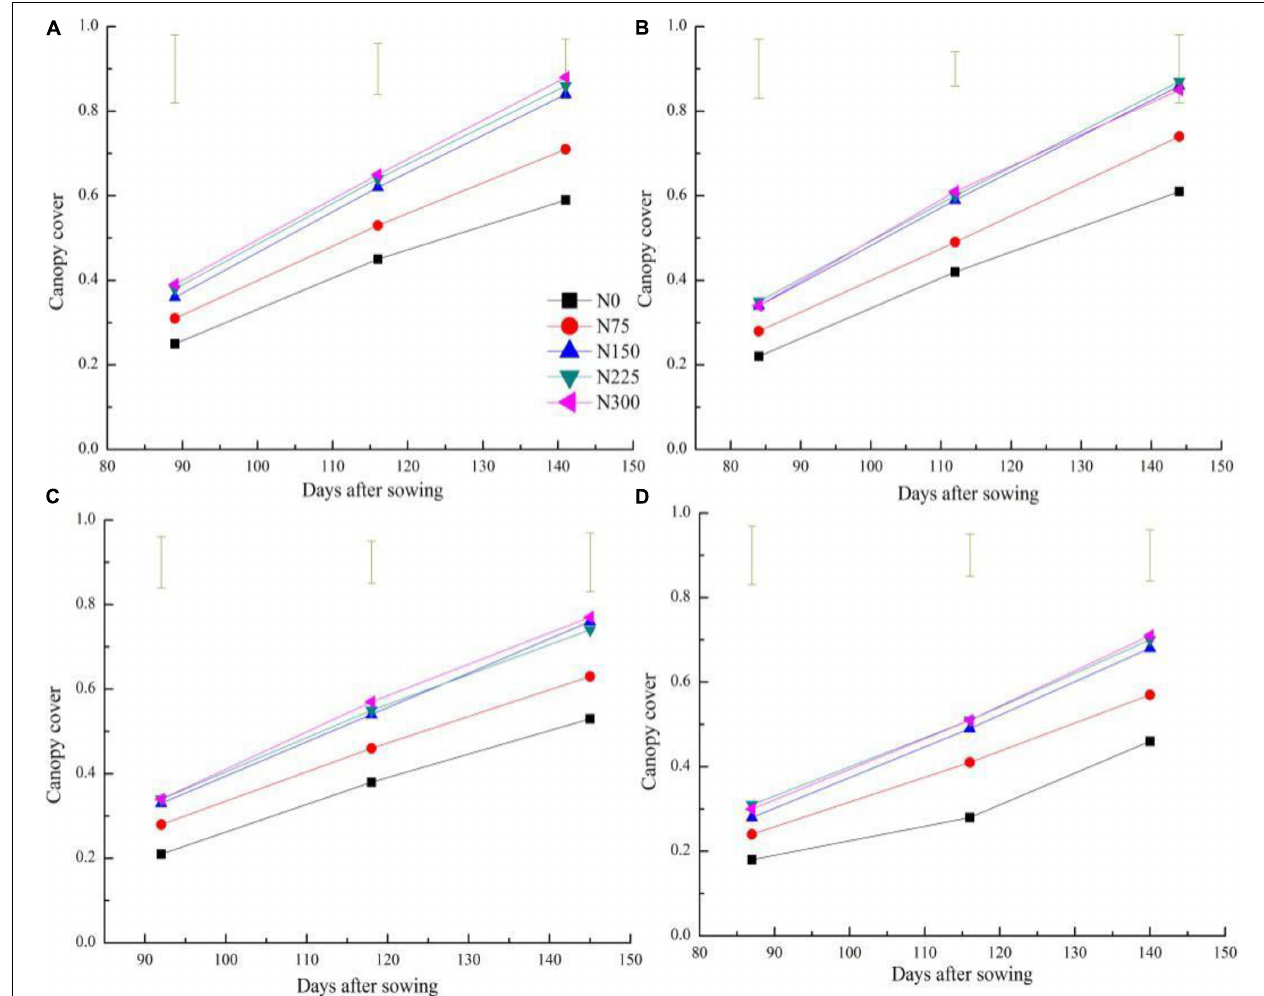
FIGURE 1 | Changes of of canopy cover (CC) across different nitrogen treatments and cultivars during the vegetative stage of winter wheat on 2016–2017 and 2017–2018 seasons (A) 2016–2017 AK58; (B) 2016–2017 YM58; (C) 2017–2018 BN207; (D) 2017–2018 WM28. Vertical bars represent the value of least significant difference ( P < 0.05) for each N